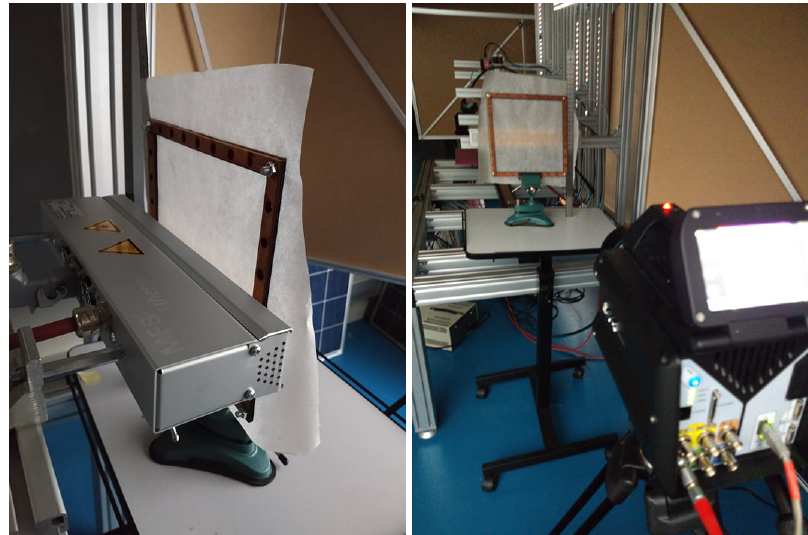
Figure 6. In the left picture, the MES-heater is visible in the measurement setup. The setup consists of the line heating source, a baking paper clamped between two wooden frames and the FLIR X6540sc infrared camera. The baking paper is used to investigate the heated area of the sample in transmission mode. The baking paper was placed at a distance of 1.5 cm from the bottom of the line heater as recommended in the datasheet.